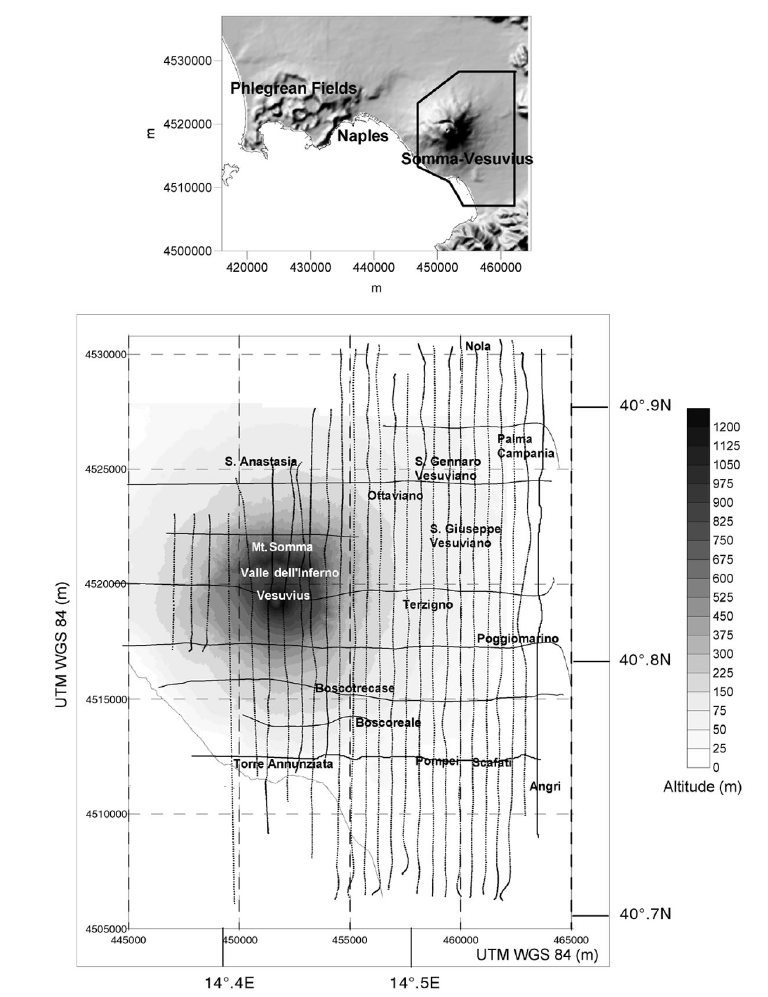
Fig. 1. Flight lines of the draped helicopter-borne survey performed in October 1999 in the Vesuvian area. The flight lines are 600 m apart, the tie lines are about 2 km apart and the sample spacing along the flight lines is 4 m. Due to the cultural noise of the area, the satellite signal used by the Global Positioning System (GPS) was not detectable in the area placed west of 14°, 43 of east